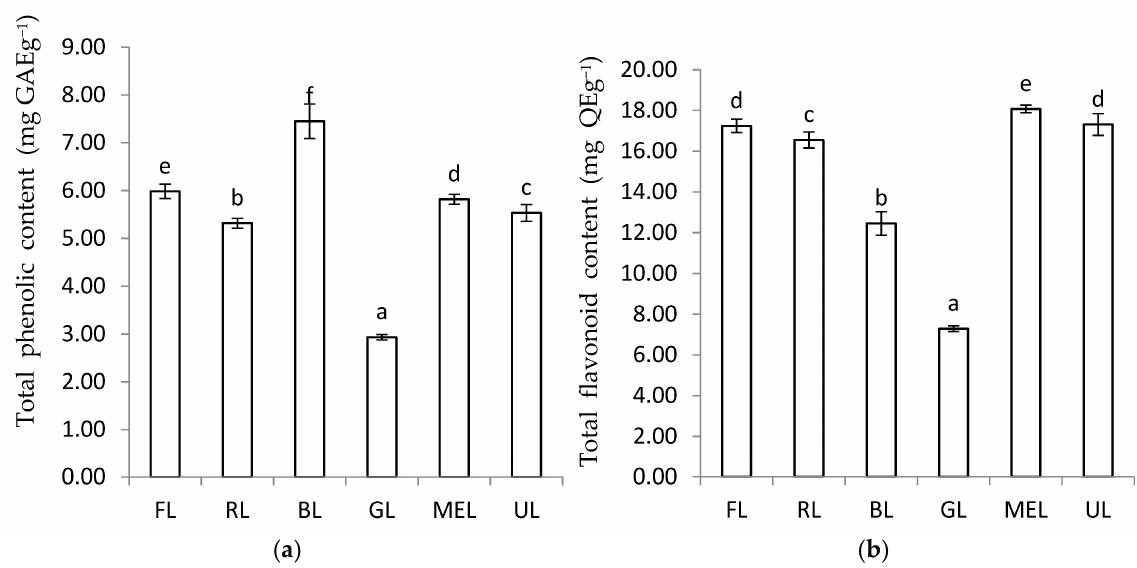
Figure 2. Effect of the light source on ( a ) the total phenolic content and ( b ) total flavonoid content of peanut sprouts. FL: fluorescent light, RL: red LED, BL: blue LED, GL: green LED, MEL: micro-electrodeless light, and UL: ultrasound+ FL. Mean values within a column with the same lowercase letters were not significantly different ( p < 0.05), according to Duncan’s multiple comparison test. Data are means ± standard deviation ( n = 3). Means with different small letters, respectively, indicate a significant difference at p < 0.05. GAE: gallic acid equivalent.